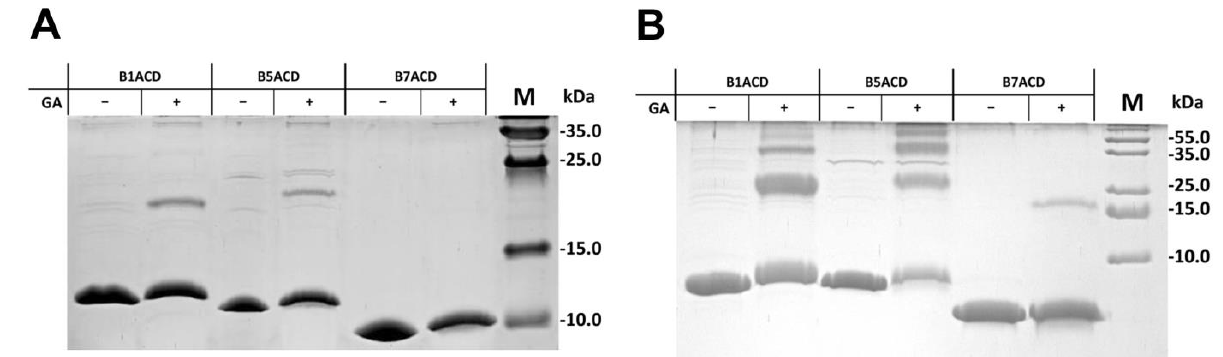
Figure 3. Chemical crosslinking of B1ACD, B5ACD and B7ACD by glutaraldehyde (GA). We cross- linked all ACDs at equal concentrations (3 mg/mL) by ( A ) 0.008% or ( B ) 0.024% glutaraldehyde and subjected them to Tricine – SDS – PAGE. Representative results of no less than five experiments